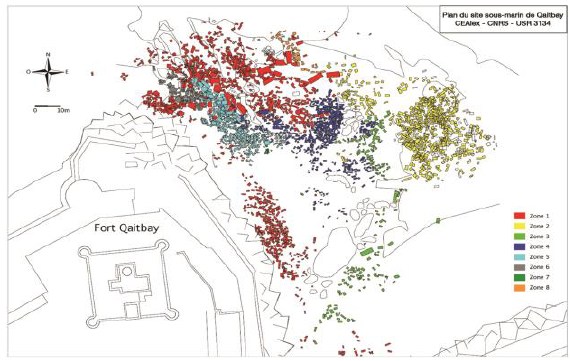
Figure 1. Map of the underwater archaeological site of